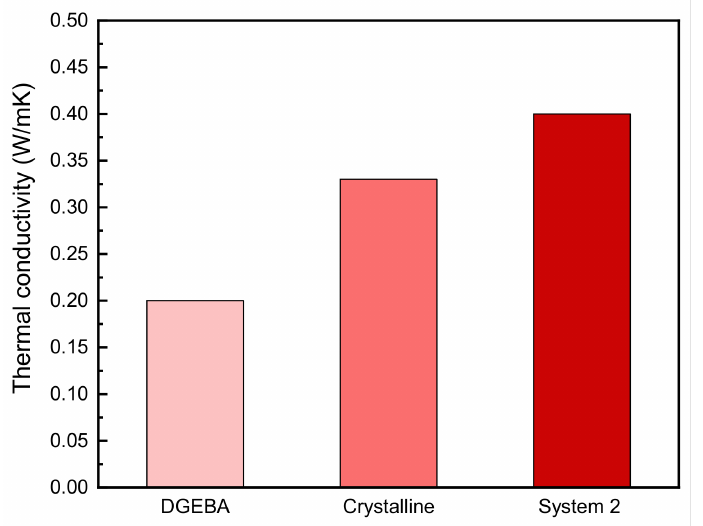
Figure 11. Thermal conductivities of DGEBA, crystalline epoxy resin, and System